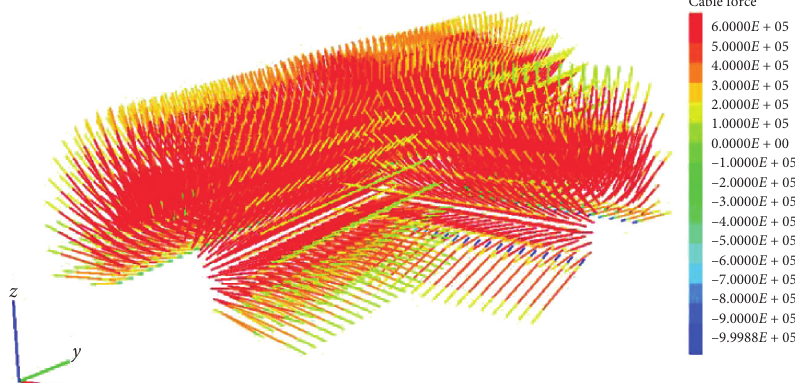
Figure 14: Axial force of anchor cable.